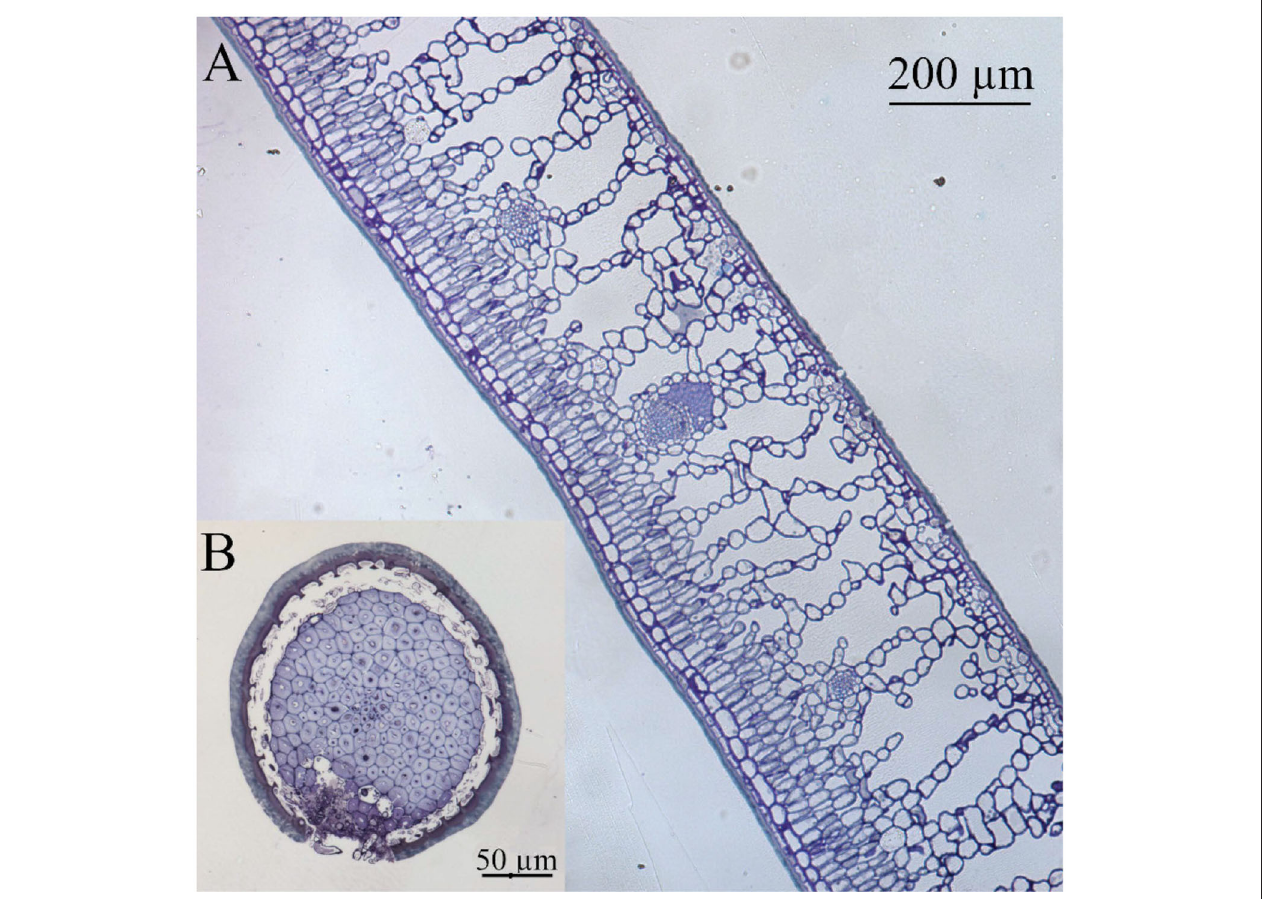
FIGURE 1 | Light microscopy cross section of (A) holly leaf and (B) spine, both showing a thick cuticle as interface with the surrounding environment. Tissues were stained with Toluidine